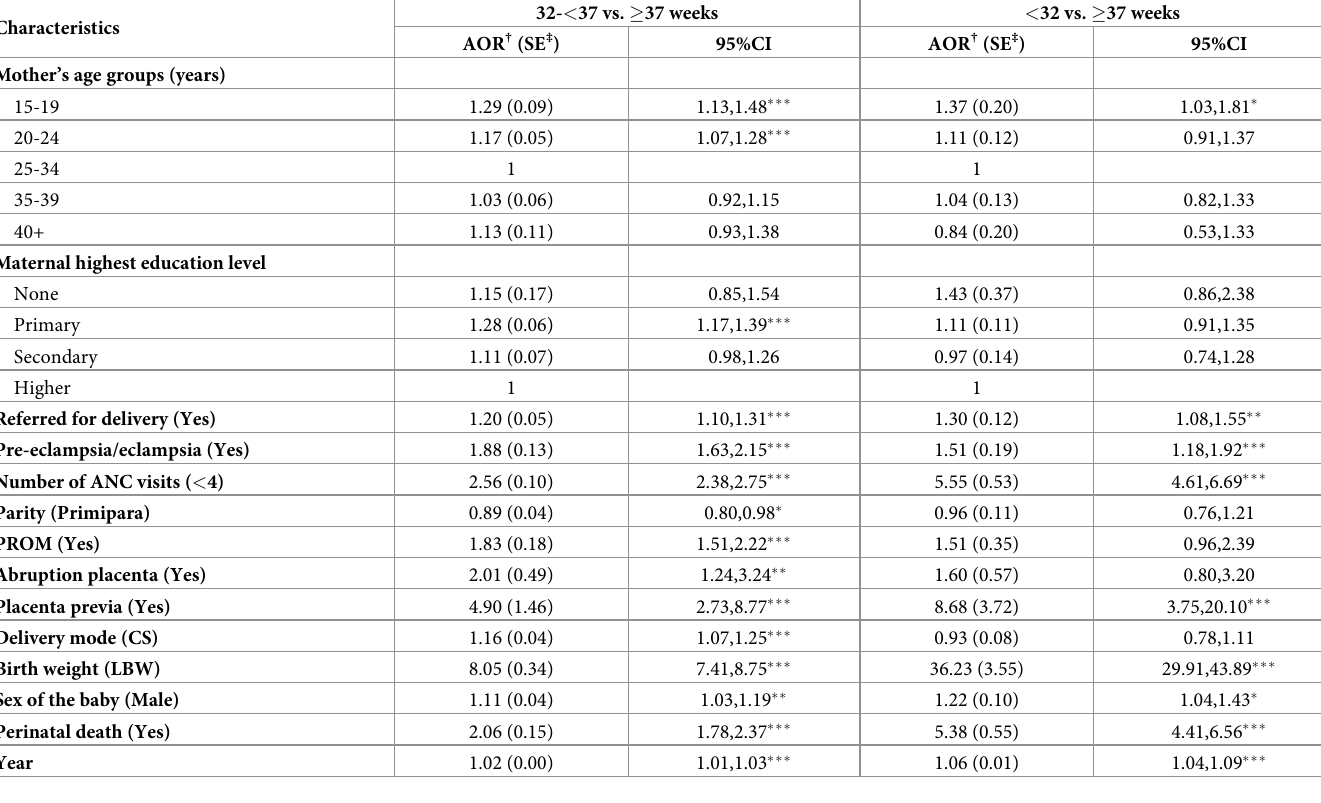
Table 4. Adjusted analysis for predictors of preterm birth using multinomial regression model before imputation of missing values (N = 41,271).